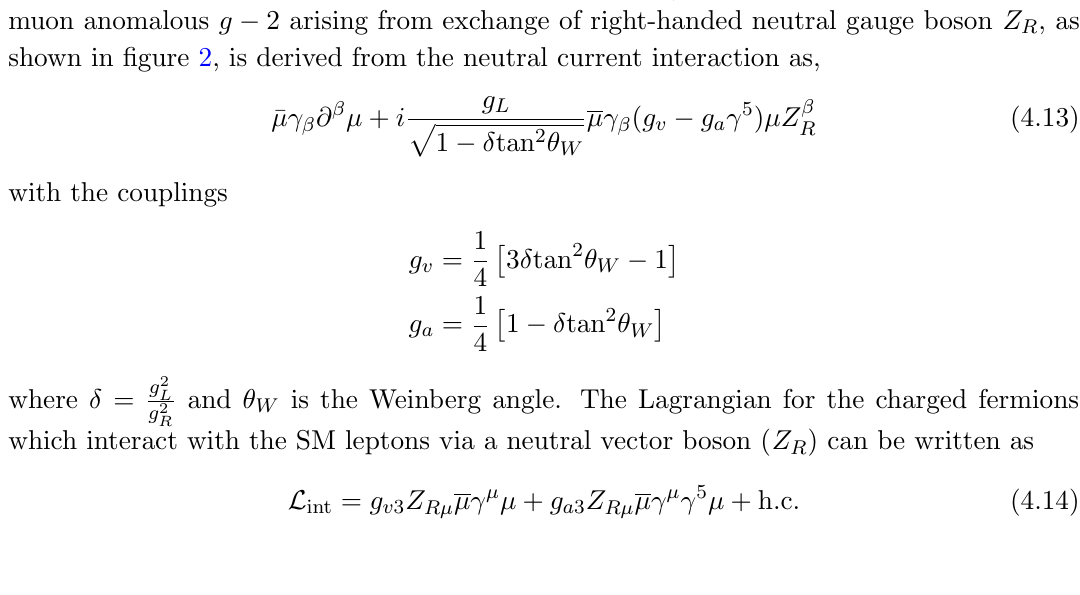
( Z ): the new contribution (cid:22) R